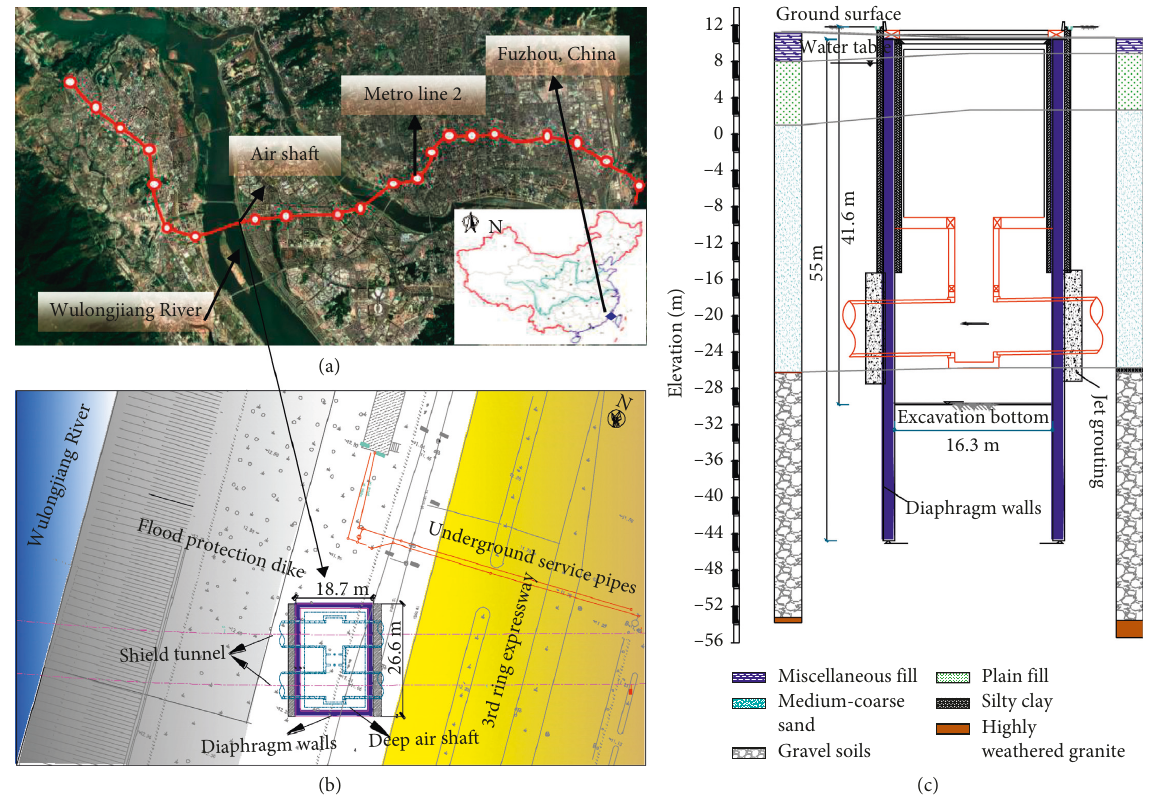
Figure 1: The layout of the air shaft. (a) Geographical location. (b) Plan view. (c) Typical strata